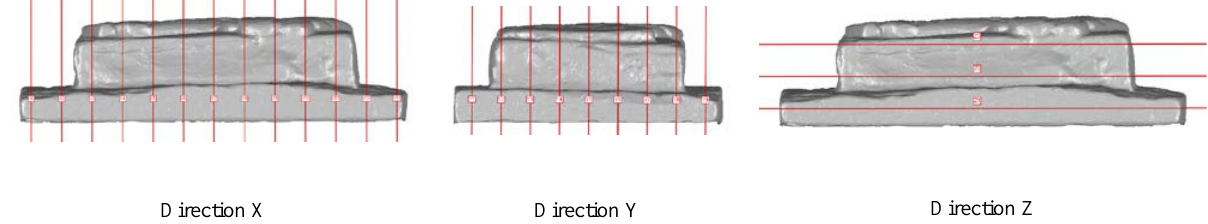
Figure 5. Location of cross-sections in three directions